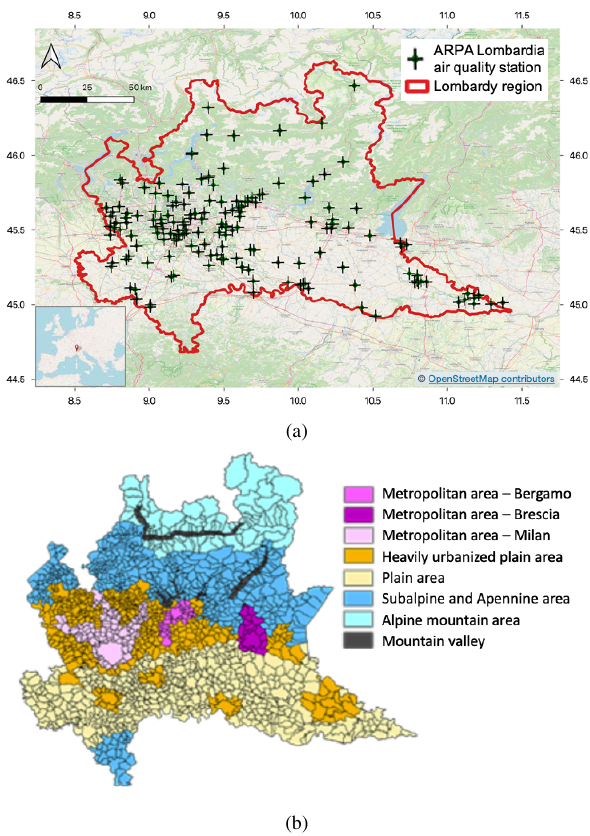
Figure 1. (a) Lombardy region area and ARPA Lombardia air quality sensors locations (coordinates reference system: WGS84). (b) Lombardy region zonation schema adopted